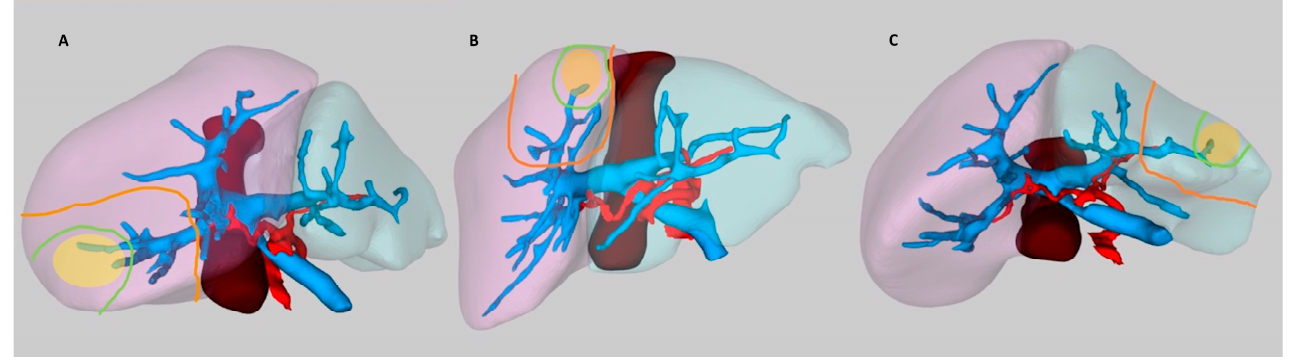
Figure 1. Anatomic (orange line) and non-anatomic (green line) resection lines in different tumor scenarios of the same liver on 3D images. ( A ) Tumor occupying segment 6-7 junction, right inferolateral view; ( B ) Tumor in the Segment 8, anterior view; ( C ) Tumor in the segment 3, inferior view. Right hemiliver (purple), left hemiliver (turquoise), portal vein (blue), hepatic artery (red), vena cava inferior (brown), tumor (yellow). Images were created with Livervision (LiverVision™, Medivision Ltd. Ankara, Turkey).